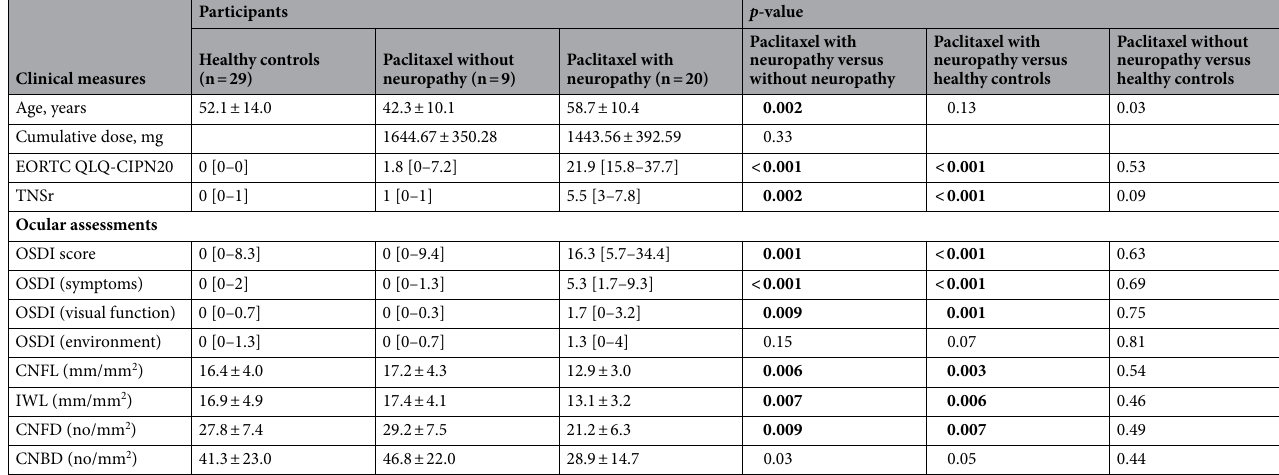
Table 3. Clinical characteristics and assessment results of patients who completed chemotherapy with paclitaxel subcategorized into those with neuropathy and those without neuropathy. EORTC QLQ- CIPN20, The European Organization for Research and Treatment of Cancer Quality of Life Questionnaire in Chemotherapy-induced Peripheral Neuropathy Questionnaire scale; TNSr, reduced Total Neuropathy Scale; OSDI, Ocular Surface Disease Index; CNFL, corneal nerve fiber length; IWL, inferior whorl length; CNFD, corneal nerve fiber density; CNBD, corneal nerve branch density. Data is reported as mean ± standard deviation, or median with interquartile range [Quartile 1–Quartile 2]. Multiple comparisons were conducted with Kruskal–Wallis test with Bonferroni adjustment applied (0.05/3 = 0.017). Significant results ( p ≤ 0.017) are presented in